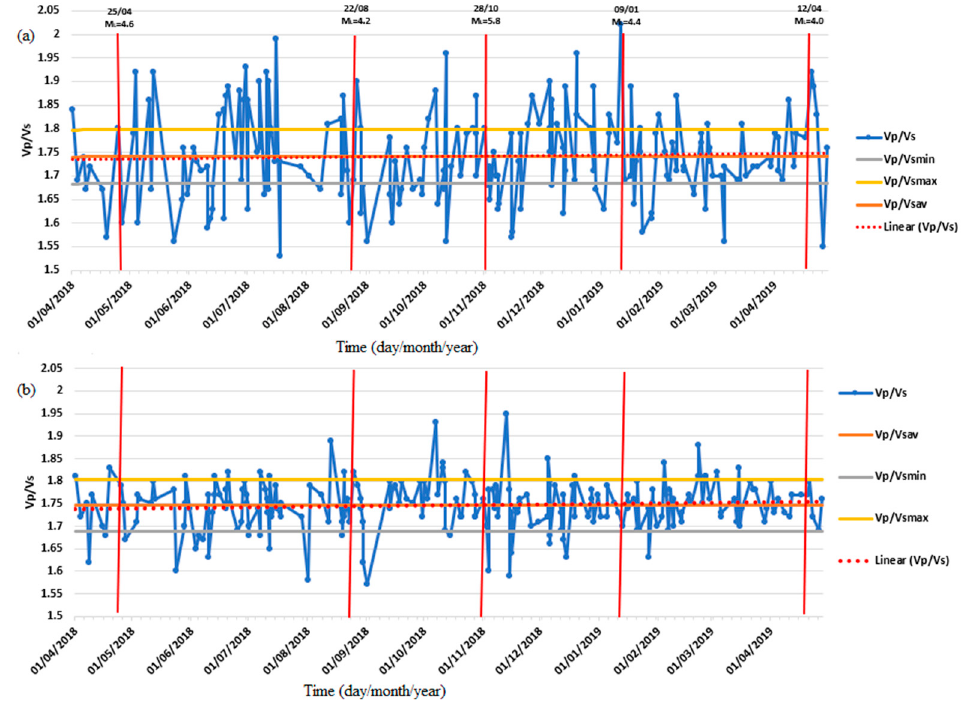
Figure 6. Vp/Vs variation over time, in the period 1 April 2018–30 April 2019, ( a ) determined using data from stations located at epicentral distances less than 1-degree and ( b ) determined with all available data. Significant earthquakes produced during the specified time period are marked with red vertical lines.